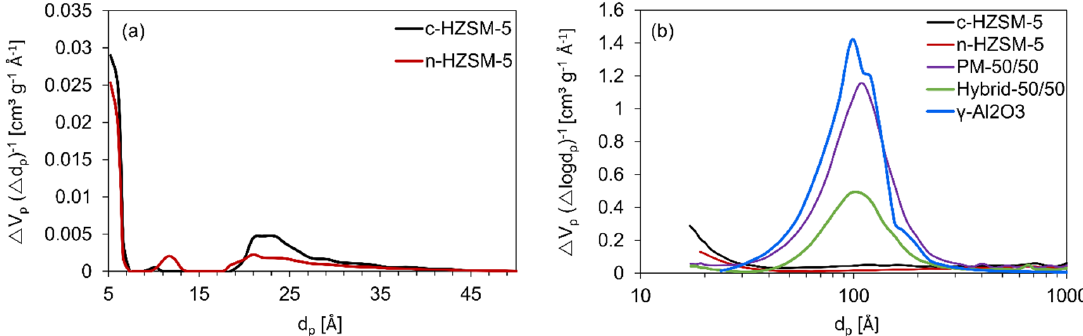
Figure 3. Non-local density functional theory (NLDFT) pore size distribution of c-HZSM-5 and n-HZSM-5 ( a ), and Barrett, Joyner, and Halenda (BJH) pore size distribution of the catalysts studied in this work ( b ). Table 2. Textural properties of the catalysts used in this work.